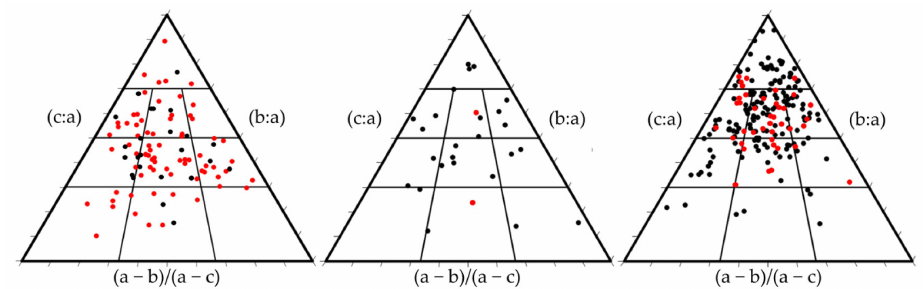
Figure 3. Triplot graphs with rhodolith (only >2 cm) shapes at Egadi, Pontine, and Sardinia stations, respectively. Black is for pralines, and red is for